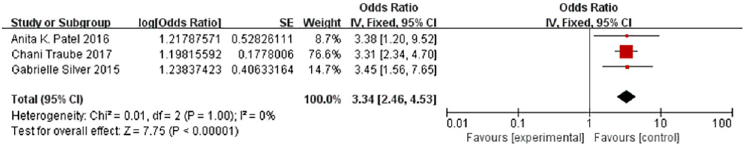
random effects model due to the potential heterogeneity among the studies. The combined effect was statistically significant [OR = 3.34, 95% CI (2.46–4.53), Z = 7.75, P < 0.001], suggest- ing that developmental delay is an independent influencing factor for the occurrence of paedi- atric delirium (Fig 2). Publication bias was not apparent according to Egger’s test outcomes [ t = 1.540, P = 0.366]. 3.3.2 The effects of mechanical ventilation on PICU delirium. The effects of mechanical ventilation on paediatric delirium were discussed in seven articles [18–22, 24, 25]. The hetero- geneity test suggested strong heterogeneity among the selected studies ( I 2 = 77%, P < 0.001);